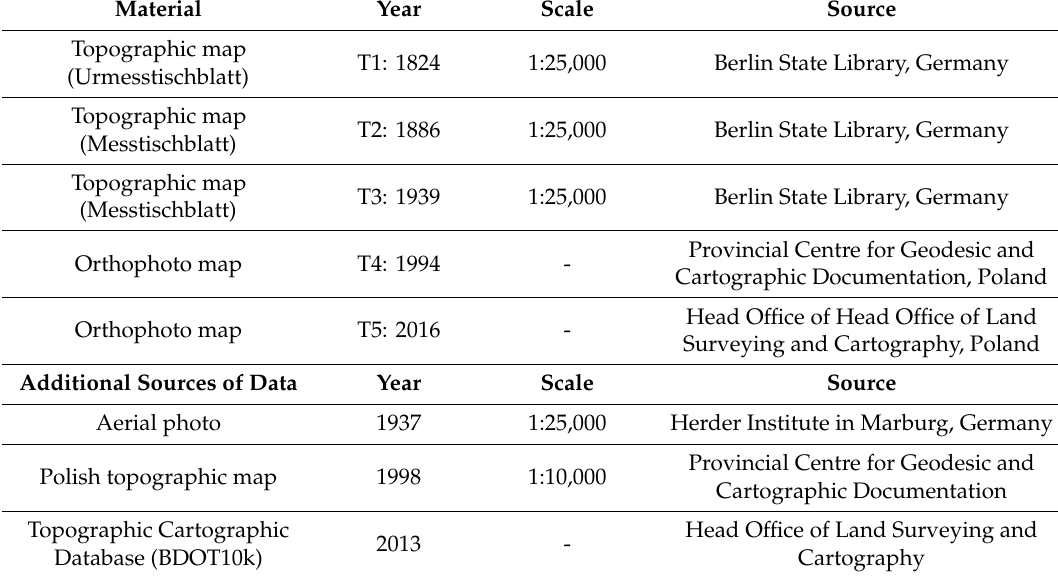
Table 1. Sources of spatial